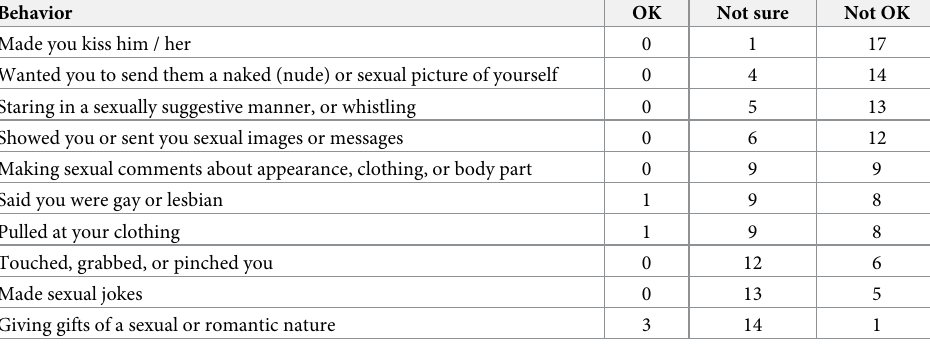
Table 3. Numbers of focus groups (total N = 18) deciding each behavior was ‘OK’, ‘not OK’ or that they were ‘not sure’—behaviors ordered according to increasing perceived acceptability. Behavior OK Not